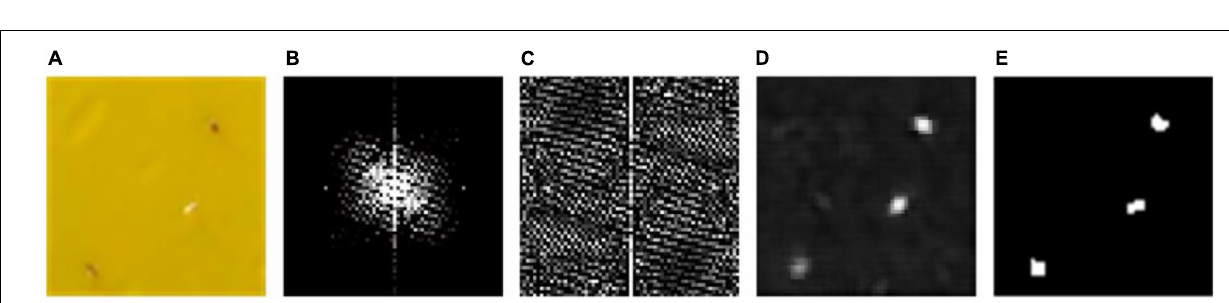
FIGURE 5 | Illustration of saliency region detection for insect pests collected on sticky traps and identified with image acquisition software: (A) a sub-block image from the sticky trap, (B) log-spectrum distribution of the sub-block, (C) the spectral residual image, (D) a saliency map of the insect pests and (E) binary image of the saliency